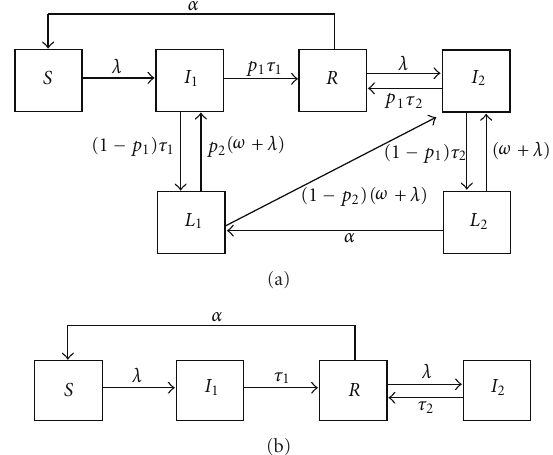
Figure 1: Plasmodium transmission dynamics. (a) Illustration of the natural history of infection with the P. vivax parasite. The variables represent a classification of the population at any given age and time into six states: completely susceptible ( S ); clinical malaria resulting from an infection in a completely susceptible individual ( I 1 ); recovered with clinical immunity without any hypnozoites ( R ); mild or asymptomatic infection resulting from exposure of recovered individuals ( I 2 ); recovered with a certain degree of clinical immunity, carrying hypnozoites ( L 1 ); recovered with clinical immunity, carrying hypnozoites ( L 2 ). Description and values for the parameters can be found in Table 1. (b) P. falciparum transmission dynamics. This is a subset of the previous system which is retrieved by making p 1 =